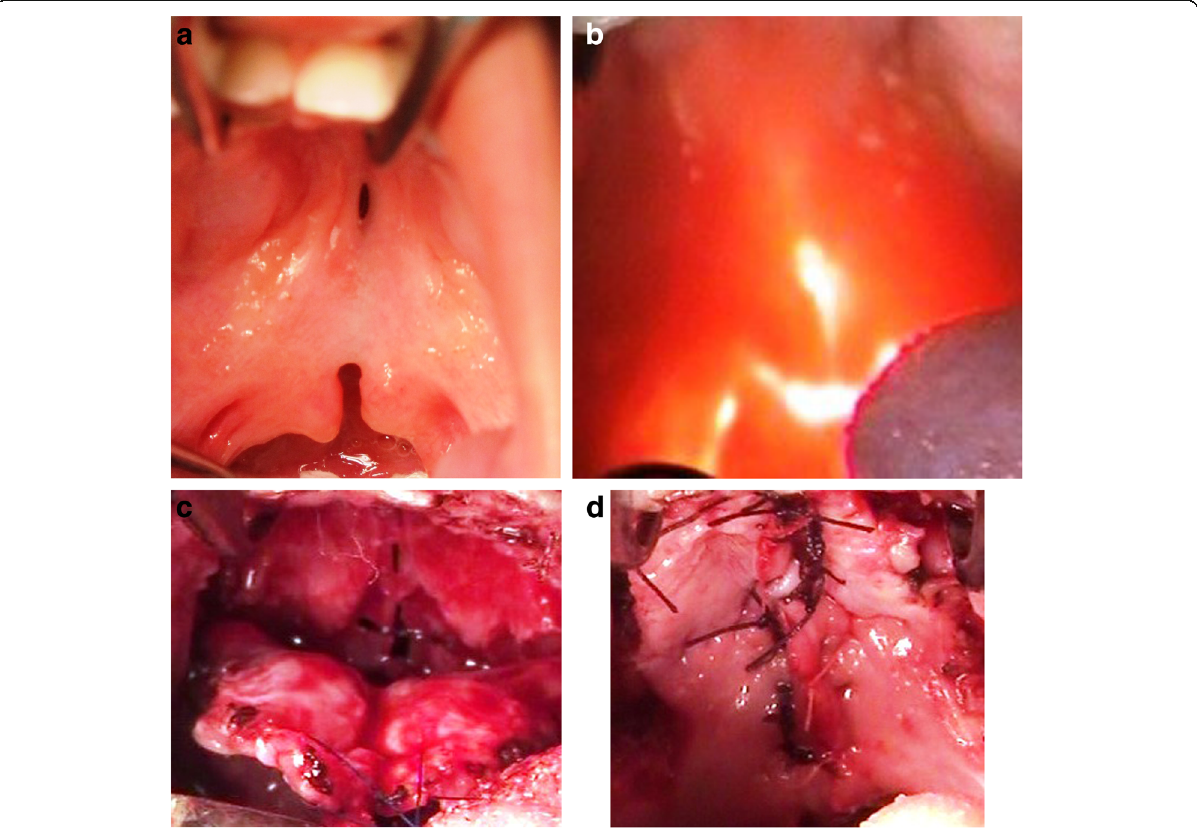
Fig. 3 a Transoral view of the bifid uvula and oronasal fistula in membranous central part of the palate anteriorly. b Transnasal transillumination of the palate showing the bifid uvula and membranous part with oronasal fistula. c Transoral dissection of the palate with elevation of two long mucoperiosteal flaps; the oronasal fistula was seen anteriorly. d Repair of the palatal muscles and mucoperiosteal flaps on oral side with 3-0 vicryl (two long palatal flap